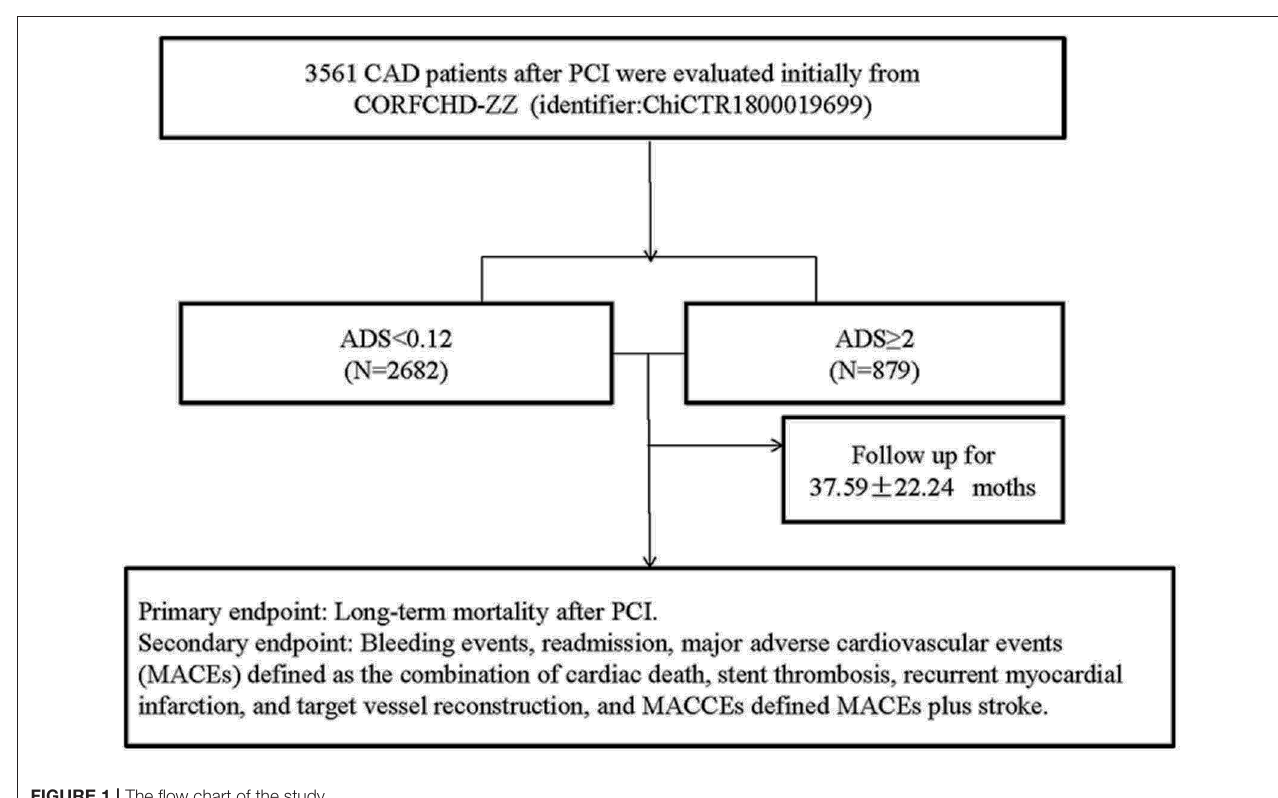
FIGURE 1 | The flow chart of the study.